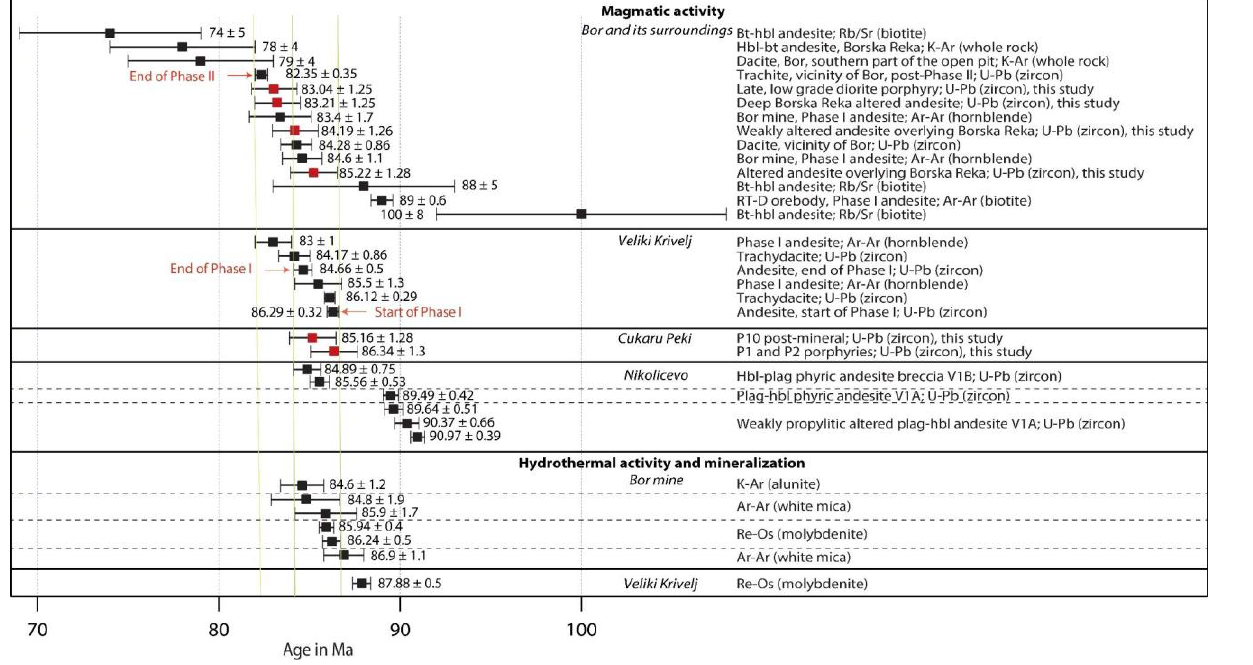
Figure 3. Geochronology of the Bor and Cukaru Peki deposits in the context of the Timok magmatic complex [15,18,20,22,24 – 26]. Start and end of Phase I, as well as end of Phase II are based on U/Pb zircon analysis and field relationships; start of Phase II cannot be constrained [20,22].